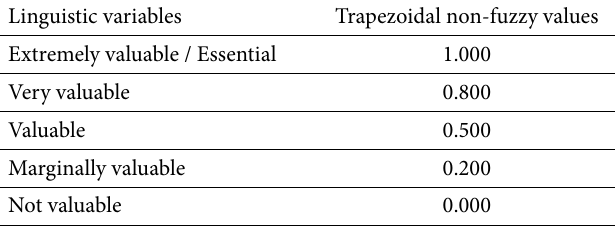
Table 2. Conversion of linguistic variables and into non-fuzzy values to establish the weights of the quality criteria Linguistic